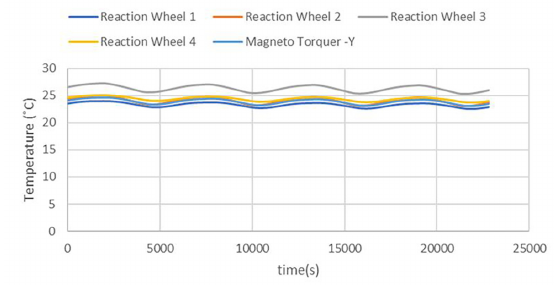
Fig. 12: Equipment temperature change on panel five.